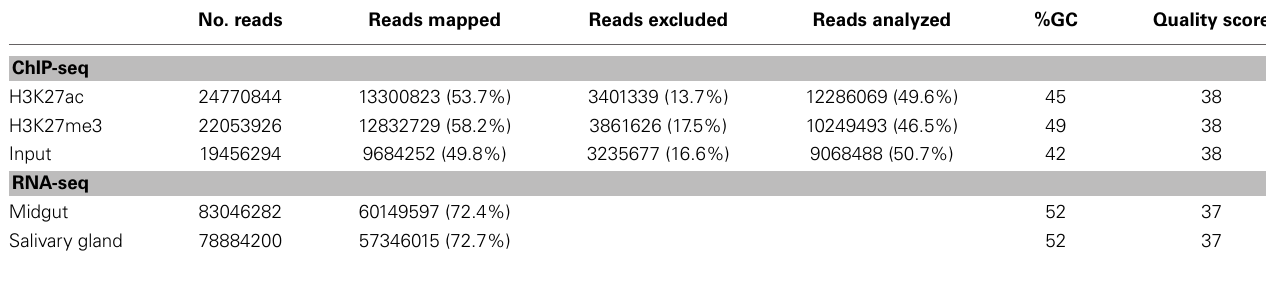
Table 1 | Statistics of ChIP-seq and RNA-seq data processing and quality checks. No.